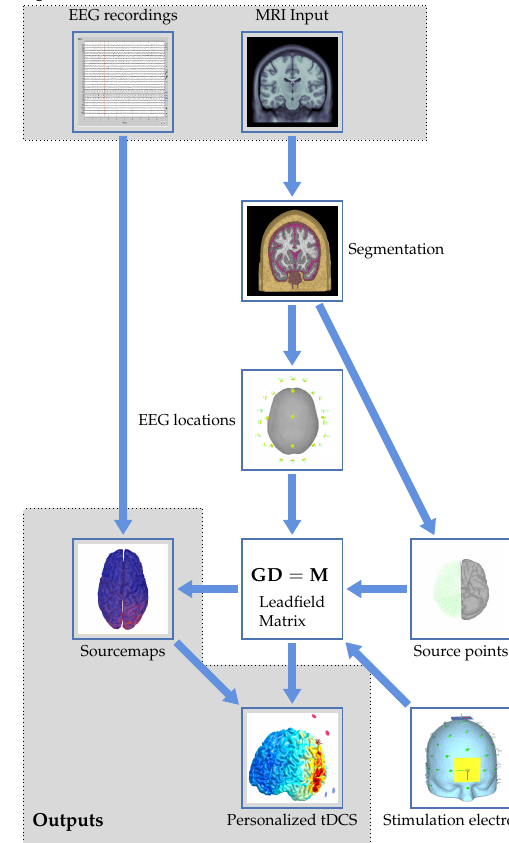
Figure 1. Graphical flowchart showing the proposed workflow to arrive at personalized tDCS from EEG and MRI